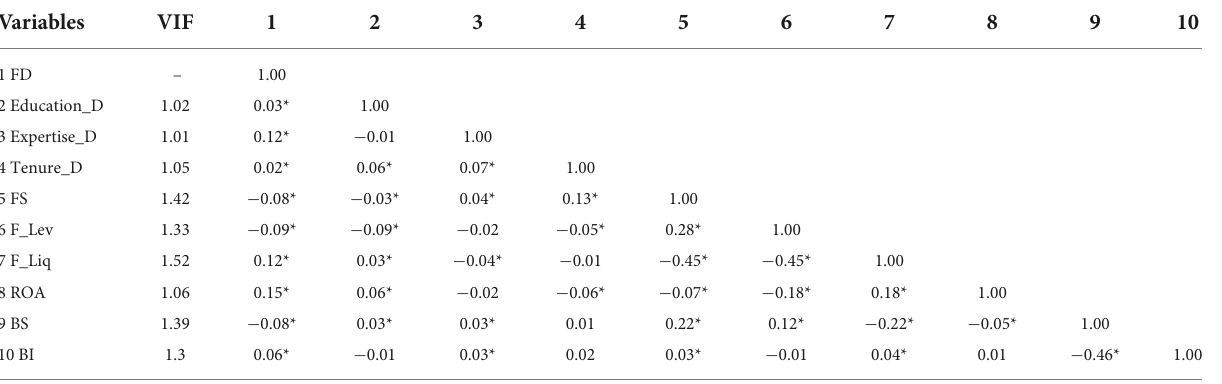
TABLE 4 Variance inflation factor (VIF) and correlation matrix. Variables